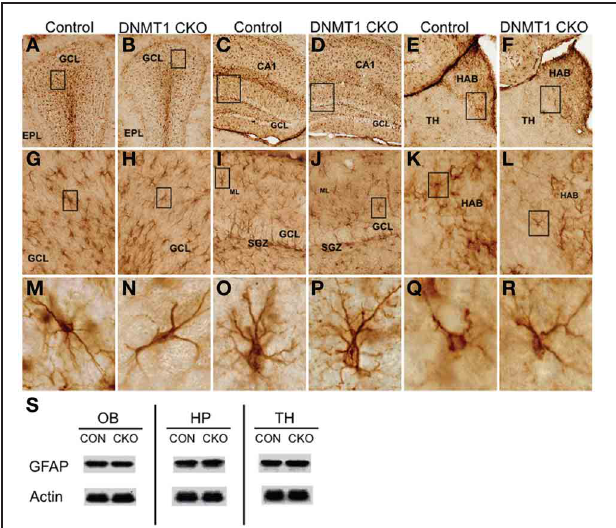
FIGURE 3 | Normal appearance of mature astrocytes and normal levels of GFAP in DNMT1-cKO mice. (A–R) Survey and detail of frontal sections through the olfactory bulb (A,B) , hippocampus (C,D) , and medial habenular nucleus (E,F) stained for GFAP. DNMT1-cKO tissue exhibits no detectable difference in the number or distribution GFAP positive astrocytes at the survey (A–F) , intermediate (G–L) , or single cell (M–R) levels in any area. Boxes indicate region shown at higher magnification in image below. Note that GFAP-positive progenitors in the subgranular zone (SGZ) of dentate gyrus (DG) are depleted as expected in DNMT1-cKO mice (J) as compared with control mice (I) . (S) Western blots show that levels of GFAP are indistinguishable between controls and DNMT1-cKO mice in olfactory bulb (OB), hippocampus (HP), and thalamic (TH) tissue. GCL, granule cell layer; EPL, external plexiform layer; HAB, habenula; ML, molecular layer; SGZ, subgranular zone; Con, control; CKO, conditional knockout.